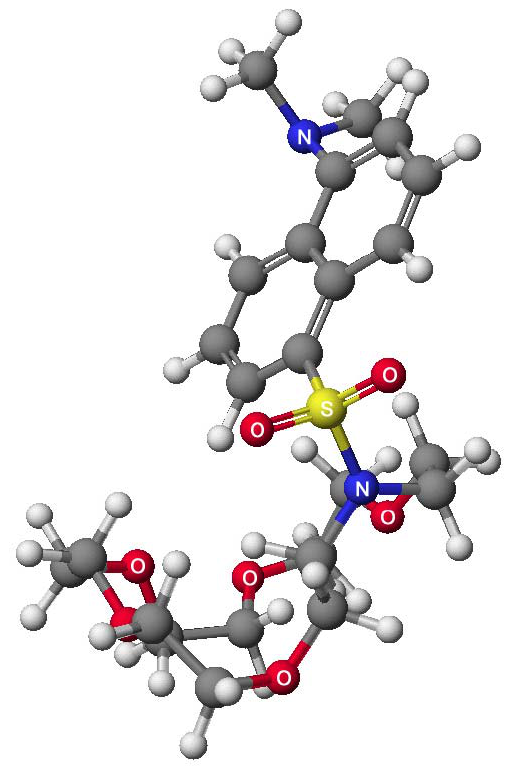
Fig. 6 The optimalized structure of